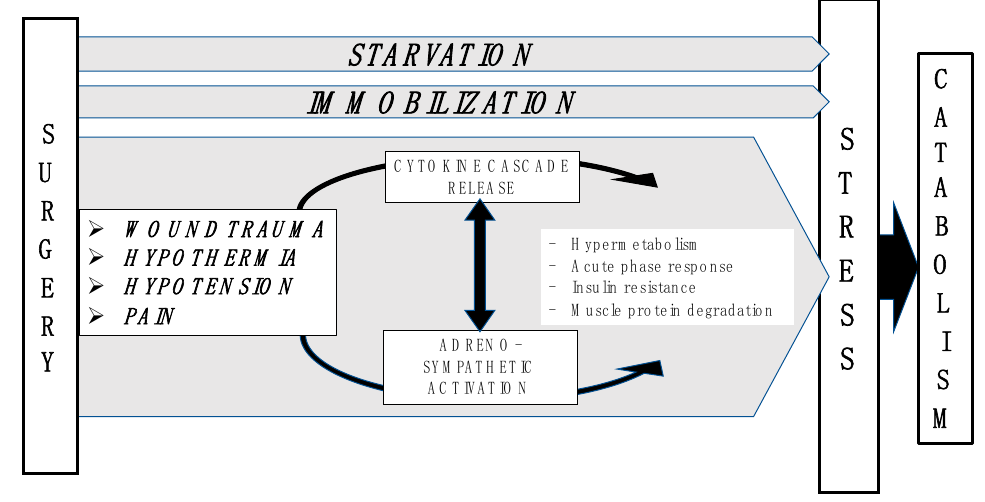
Figure 1. The main causes of metabolic changes consequent to surgery.